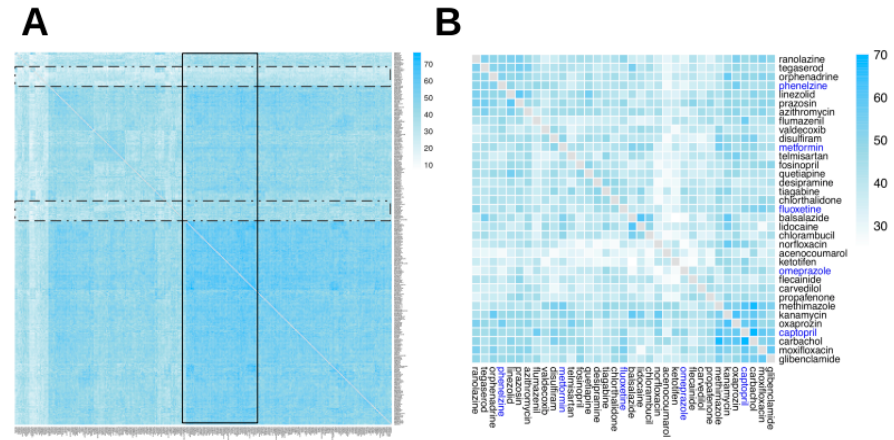
Figure 4. Heatmap of two-drug combination cADRs via mode 1 configuration. The mode 1 configuration indicates that the two drugs in the combination may perturb the same GO term, which in turn may lead to cADR manifestation. The heatmap is organized using a hierarchical clustering. The heatmap indicates that most drug pairs have a large number of mode 1 configurations. ( A ) The complete heatmap, containing all 315 drugs; two narrow bands of drugs with few mode 1 configurations (dotted rectangles) and a wide band of drugs with many mode 1 configurations (solid line rectangle) are shown. ( B ) A subset of the heatmap, containing 35 drugs: five drugs highlighted in blue, which are used in examples in the Discussion section, and the six drugs most similar to each of them (in terms of the number of instances of mode 1 configurations) from Panel